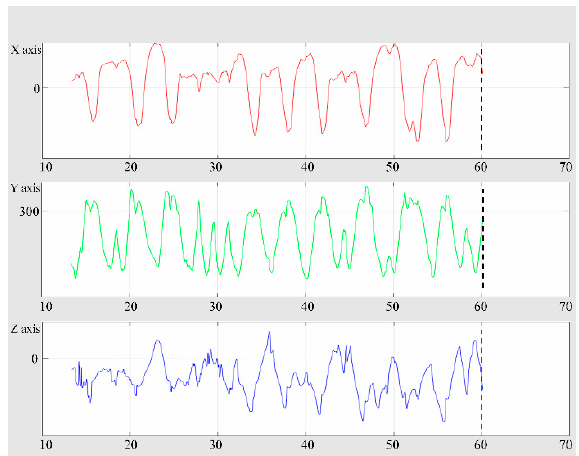
Figure 6. Ability to stretch the user’s hand and analyze the movement of each axis with time. The X axis according to time is width movement and Y axis is longitudinal movement. Also, Z axis means the depth of movement. The algorithm developed in this study enables stretch measurements (tremor) that could not be done in conventional BBT. It is also possible to analyze objective hand tremors, cerebral palsy, ataxia, and Parkinson’s disease.